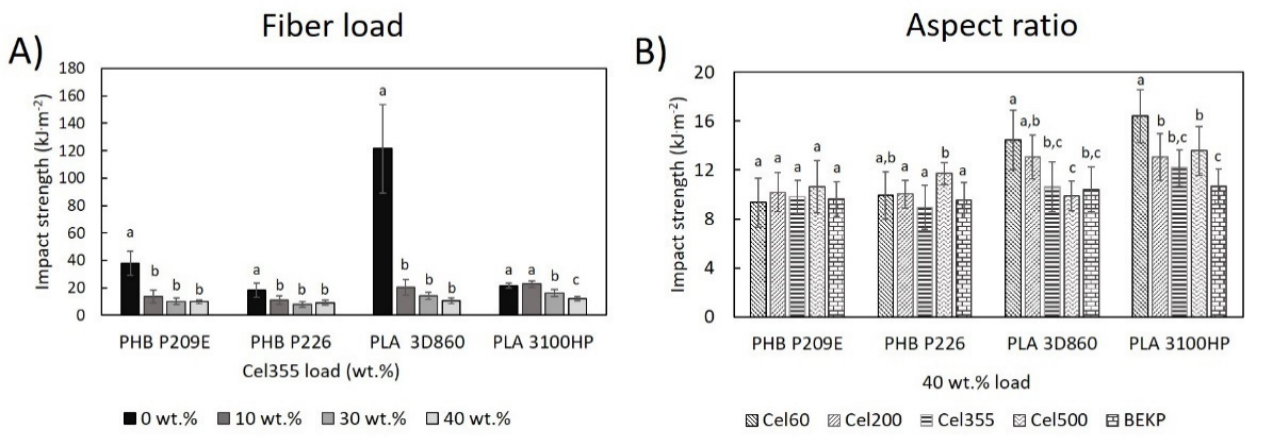
Figure 7. Impact properties of PHB- and PLA-based composites ( A ) reinforced with different loads of Cel355 and ( B ) reinforced with fibers having different aspect ratios for a load of 40 wt.%. Different letters (a,b,c) indicate statistically significant differences ( p < 0.05).